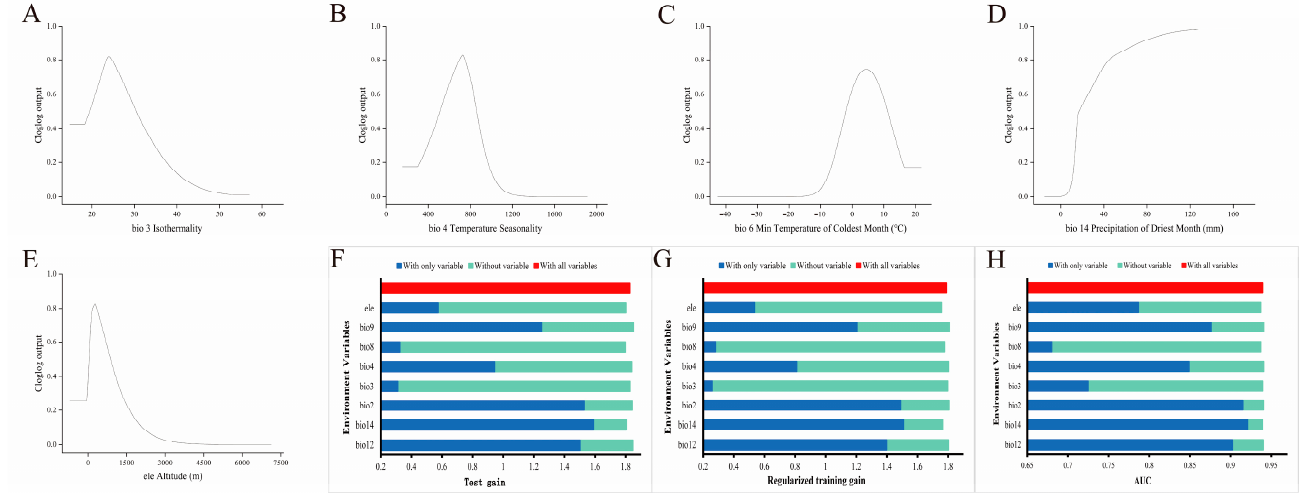
Figure 3. Response curves and Jackknife test of the environment variables. ( A – E ) Respectively repre- sent the response curves of isothermality, temperature seasonality, min temperature of coldest month, precipitation of driest month and Altitude. ( F – H ) The contribution of each environmental factor to each scenario using the Jacknife test in In test gain, regularized training gain and AUC, respectively.